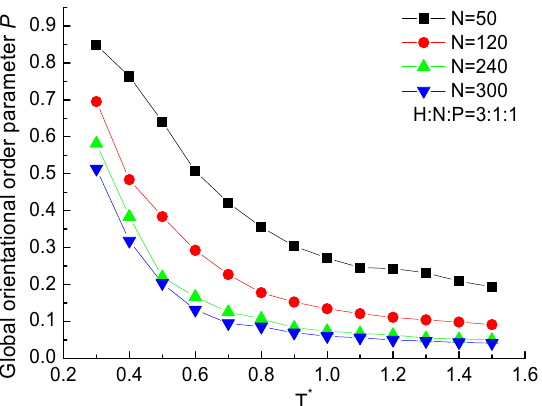
Figure 3. The global orientational order parameter P versus reduced temperature T ∗ of H3N1P1 proteins with different chain lengths.